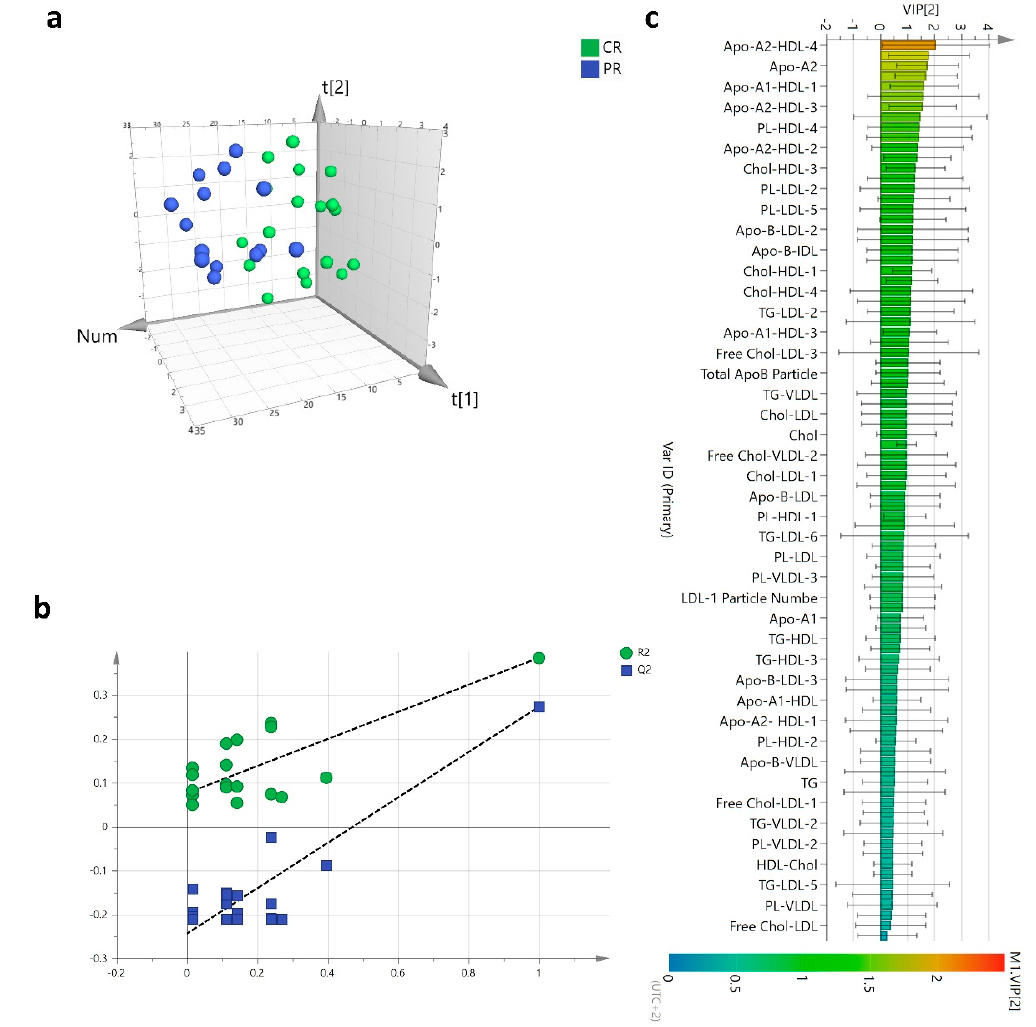
Figure 7. PLS-DA discriminated plasma lipoproteins profiles of patients achieving a CR ( n = 18), green) and a PR ( n = 14, blue) ( a ); Permutation test plot showing R 2 (green) and Q 2 (blue) values from the permuted models ( b ); Variables importance for the projection (VIP) score plot of the PLS-DA model ( c ).